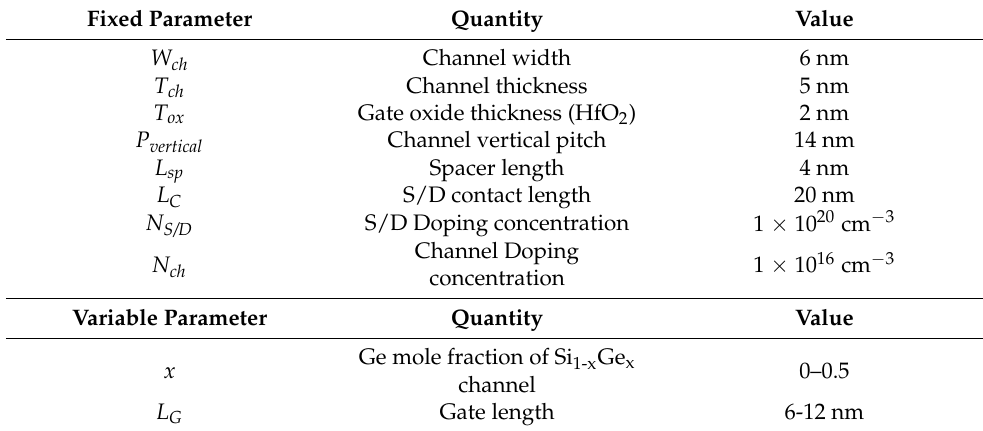
Table 1. Simulation parameters of 1 nm node CFET devices.